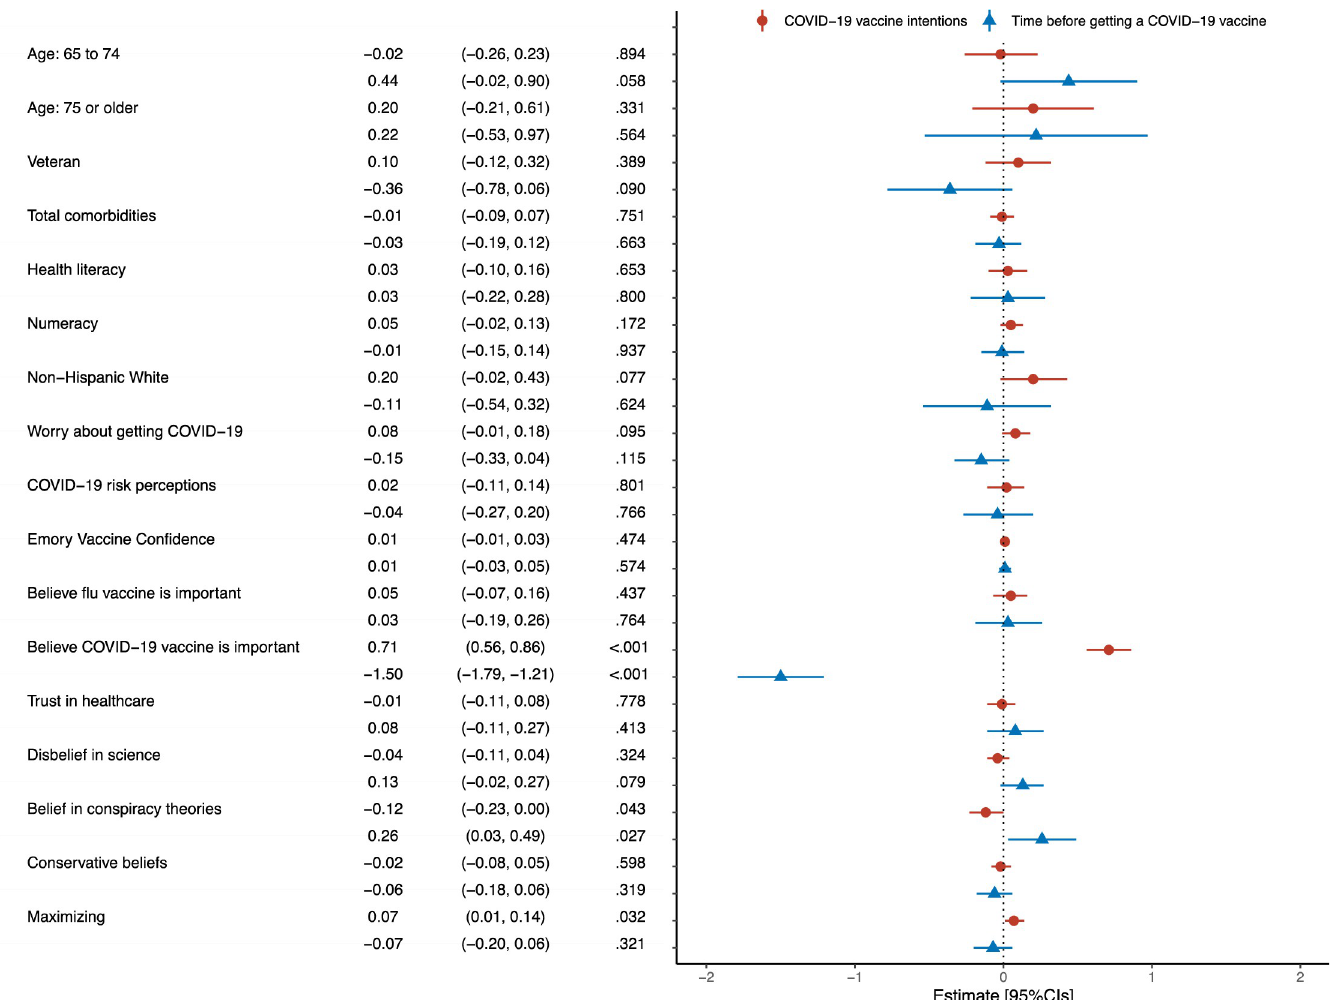
Fig 3. Predictors of respondents’ COVID-19 vaccine intentions and how long they would wait before getting a COVID-19 vaccine. Model estimates are represented by the triangular and circular point shapes with error bars for the 95% confidence intervals. Reference groups are: age: � 64, non-Veteran, and any other Race/Ethnicity. R 2 adjusted: Vaccine intentions = 0.68, Time to vaccine =